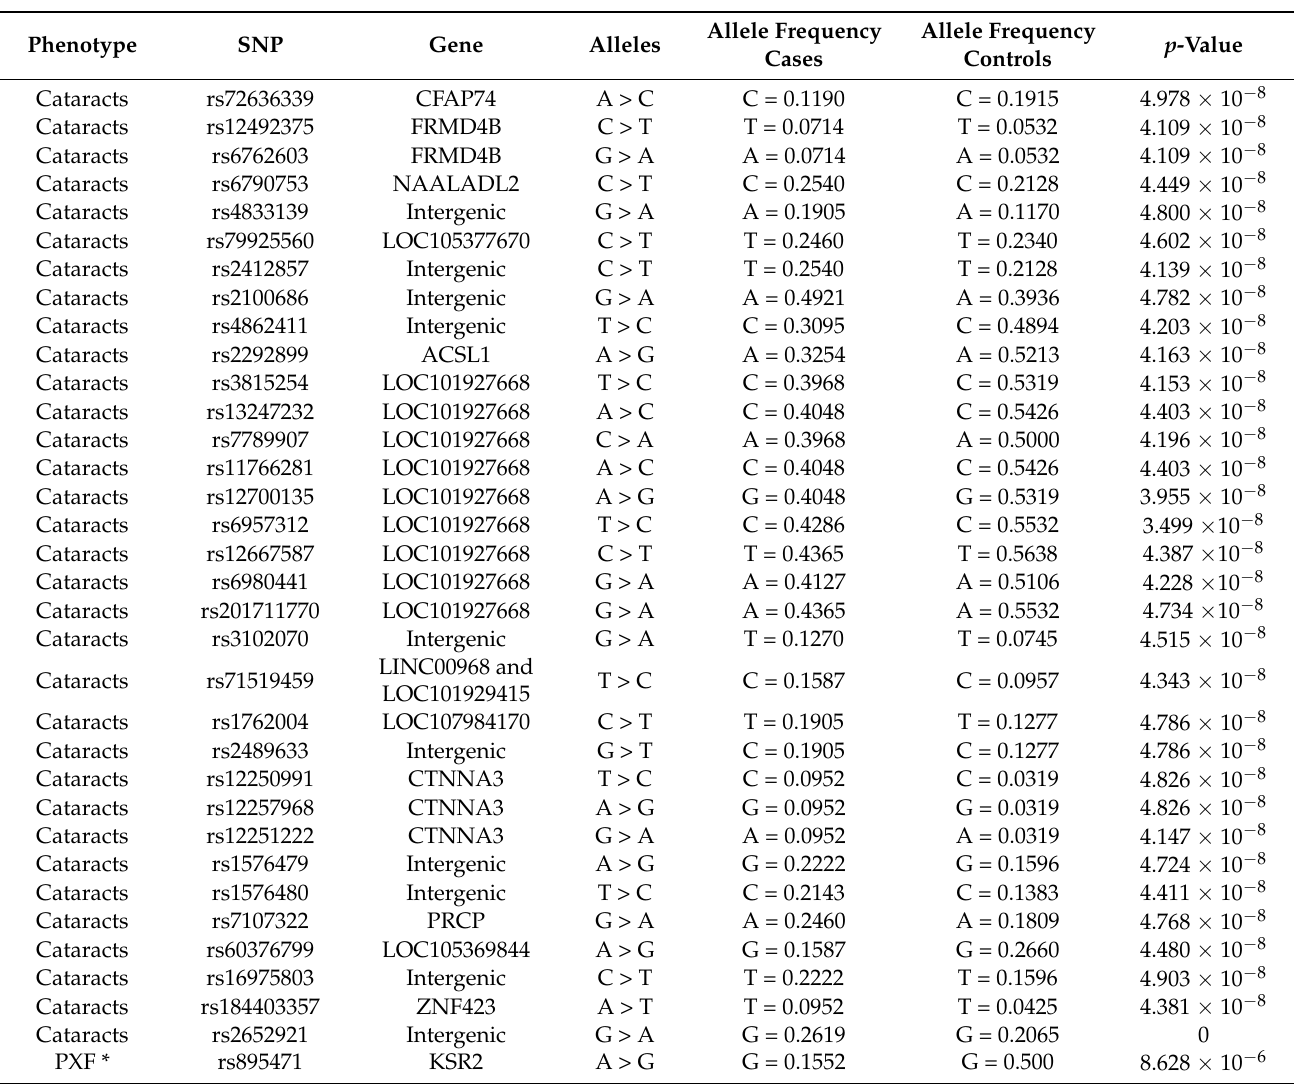
Table 7. Associated SNPs with cataracts and PXF.